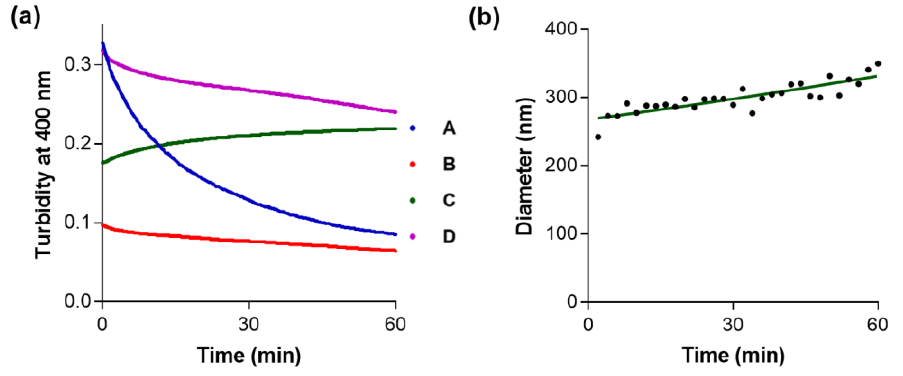
Figure 6. ( a ) Turbidity at 400 nm as a function of time measured for compounds A , B , C and D (at 500 µ M, 100 µ M, 80 µ M and 250 µ M, respectively). Each solution was prepared in HEPES buffer (10 mM), containing MgCl 2 (2 mM) and CaCl 2 (1 mM), pH = 7.4. Final concentration of DMSO in each sample was 1.0% ( v / v ); ( b ) Mean diameter ( D ) values as a function of time for compound C (80 µ M) as determined by DLS. A solution of C was prepared in HEPES buffer (10 mM), containing MgCl 2 (2 mM) and CaCl 2 (1 mM), pH = 7.4. Final concentration of DMSO in each sample was 1.0% ( v / v ).